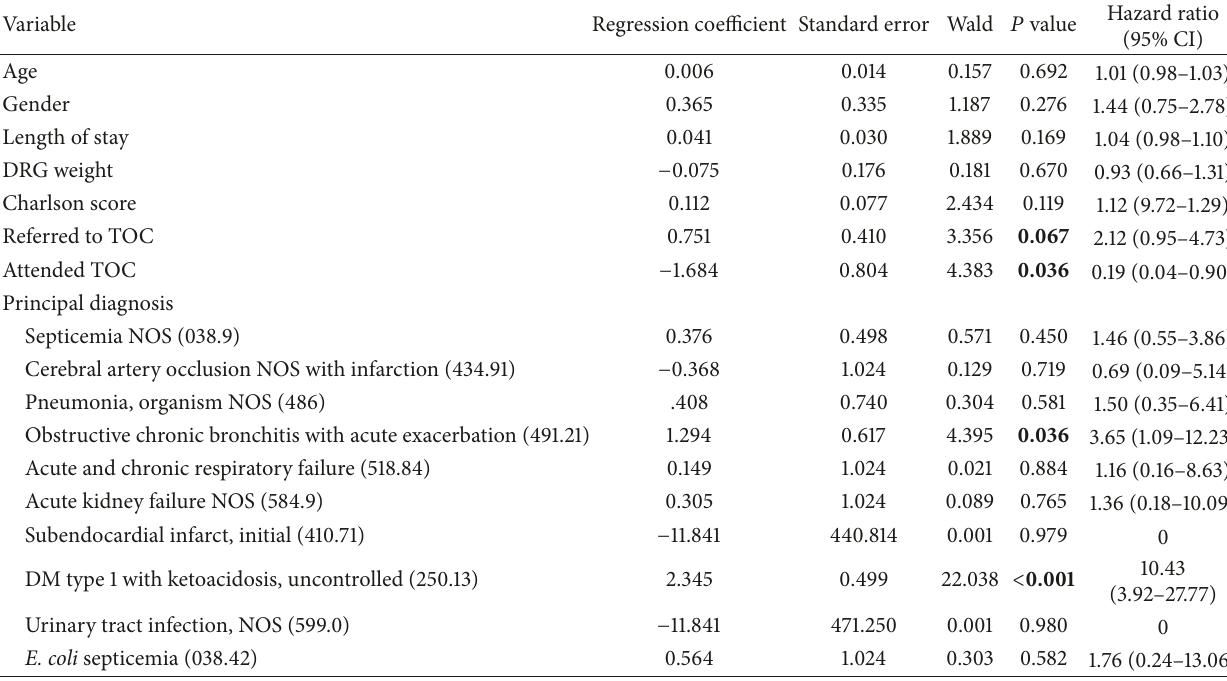
Table 2: Cox proportional-hazards regression analysis of risk factors for hospital